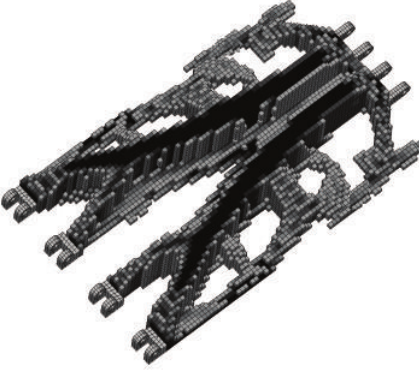
Figure 8: Topological optimized design with a temperature increase of 500 ∘